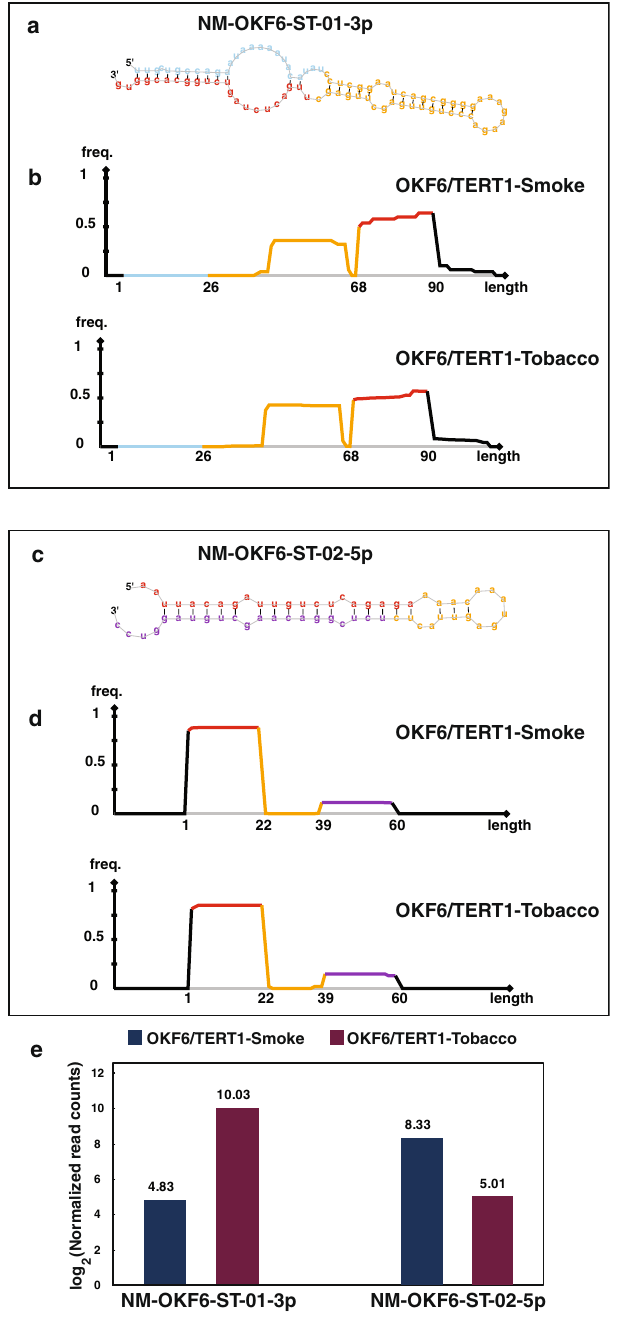
Figure 6. Expression pattern of novel miRNA common to OKF6/TERT1-Tobacco and OKF6/TERT1-Smoke cells: ( a ) Secondary structure of novel miRNA NM-OKF6-ST-01-3p identified in both OKF6/TERT1-Smoke and OKF6/TERT1-Tobacco cells ( b ) Read distribution frequency plot of NM-OKF6-ST-01-3p in OKF6/ TERT1-Smoke and OKF6/TERT1-Tobacco cells ( c ) Secondary structure of novel miRNA NM-OKF6-ST-02-5p identified in OKF6/TERT1-Smoke and OKF6/TERT1-Tobacco cells ( d ) Read distribution frequency plot of NM-OKF6-ST-02-5p precursor in OKF6/TERT1-Smoke and OKF6/TERT1-Tobacco cells ( e ) Expression pattern of NM-OKF6-ST-01-3p and NM-OKF6-ST-02-5p in OKF6/TERT1-Tobacco and OKF6/TERT1-Smoke cells using log transformed normalized read